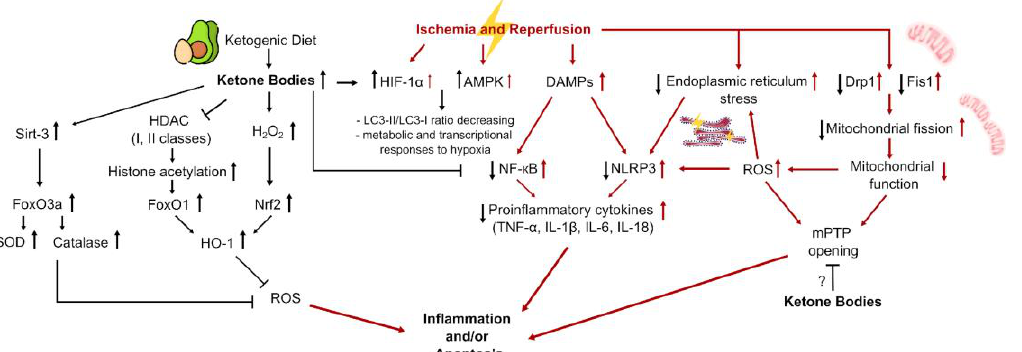
Figure 2. Possible mechanisms of the beneficial effects of KD and ketone bodies on IR injury. Red arrows indicate the effects mediated by ischemia and reperfusion, while black arrows specify the effects mediated by KD. AMPK—AMP-activated protein kinase; DAMPs, damage-associated mo- lecular patterns; Drp1—dynamin-related protein 1; FoxO3a—forkhead box protein O3a; IL-(1β, 6,